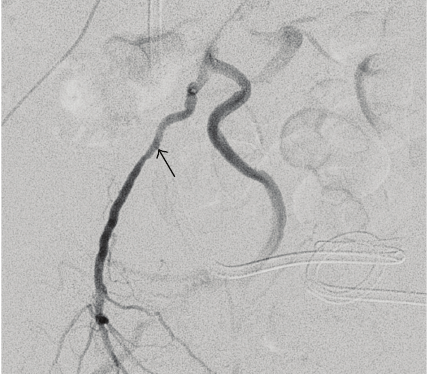
Figure 2: An angiogram showing no extravasation or fistula. How- ever, a very small pseudoaneurysm (arrow) was seen